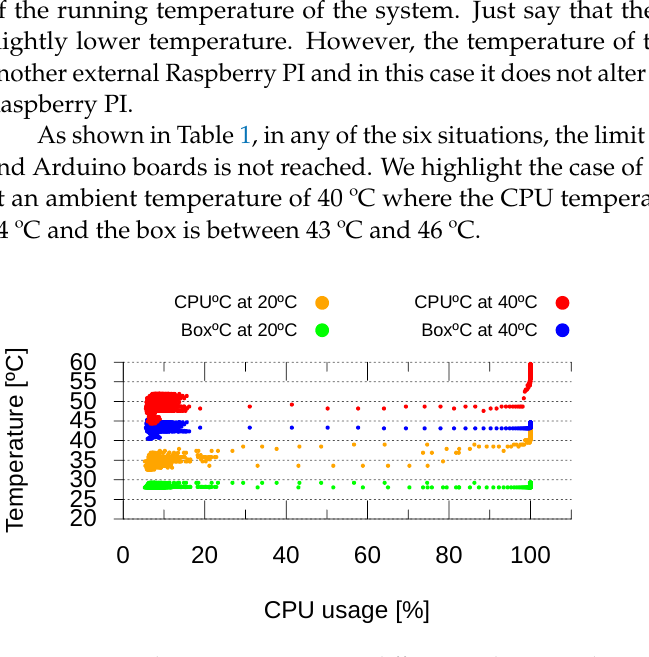
Figure 5. Box and CPU temperature in different ambient conditions and %CPU